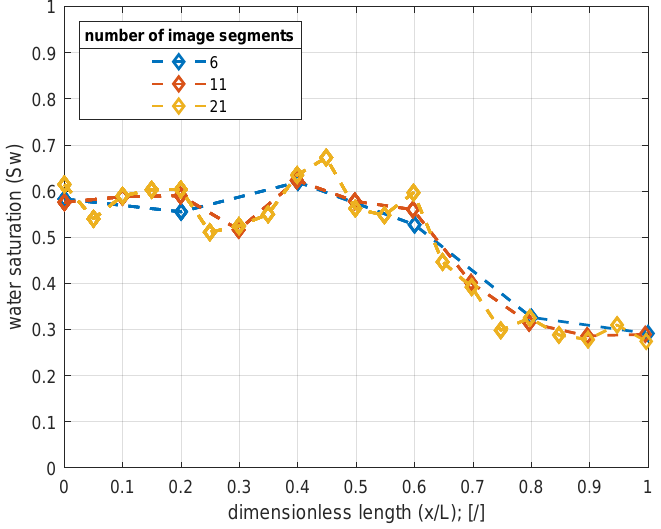
Figure 8. Local water saturation analysis for different numbers of image segments: the saturation distribution for six (blue), eleven (red), and 21 segments